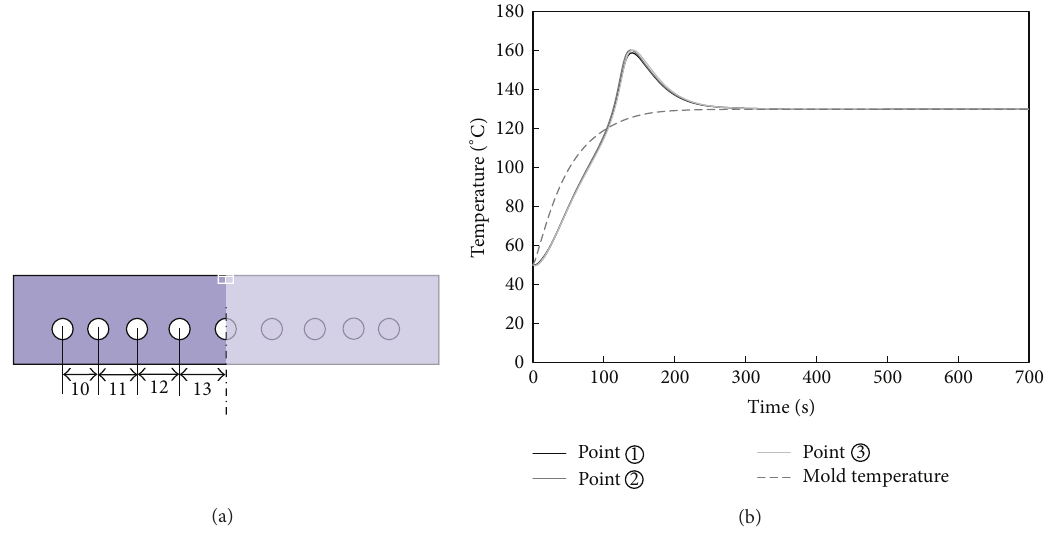
Figure 9: Temperature profile of silicone resin by heat source change: (a) optimized position of heat source for uniform heating and (b) optimized temperature profile of silicone resin and